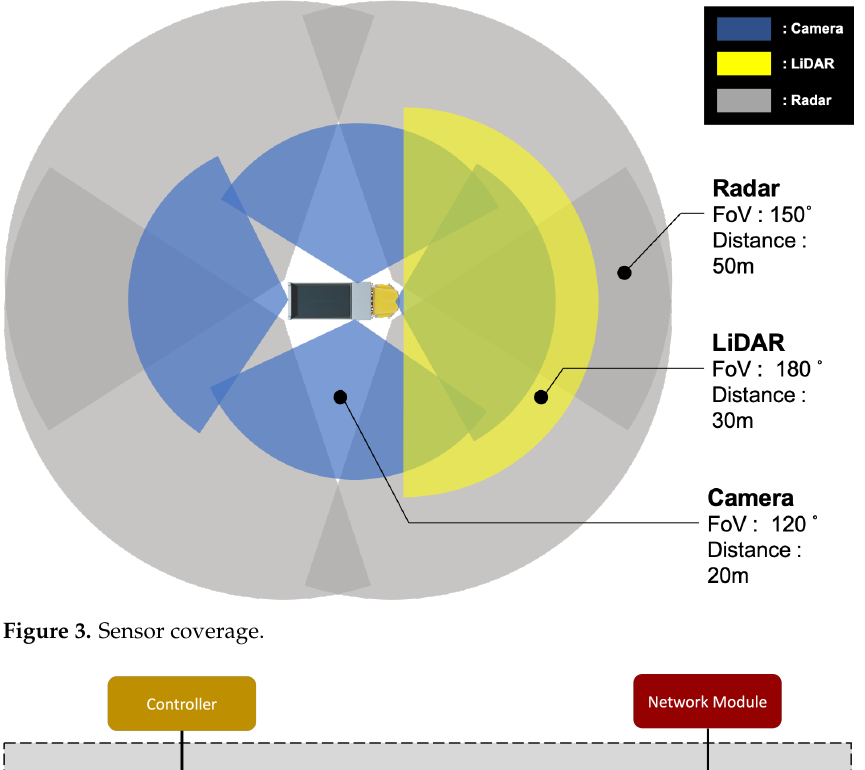
Figure 3. Sensor coverage.